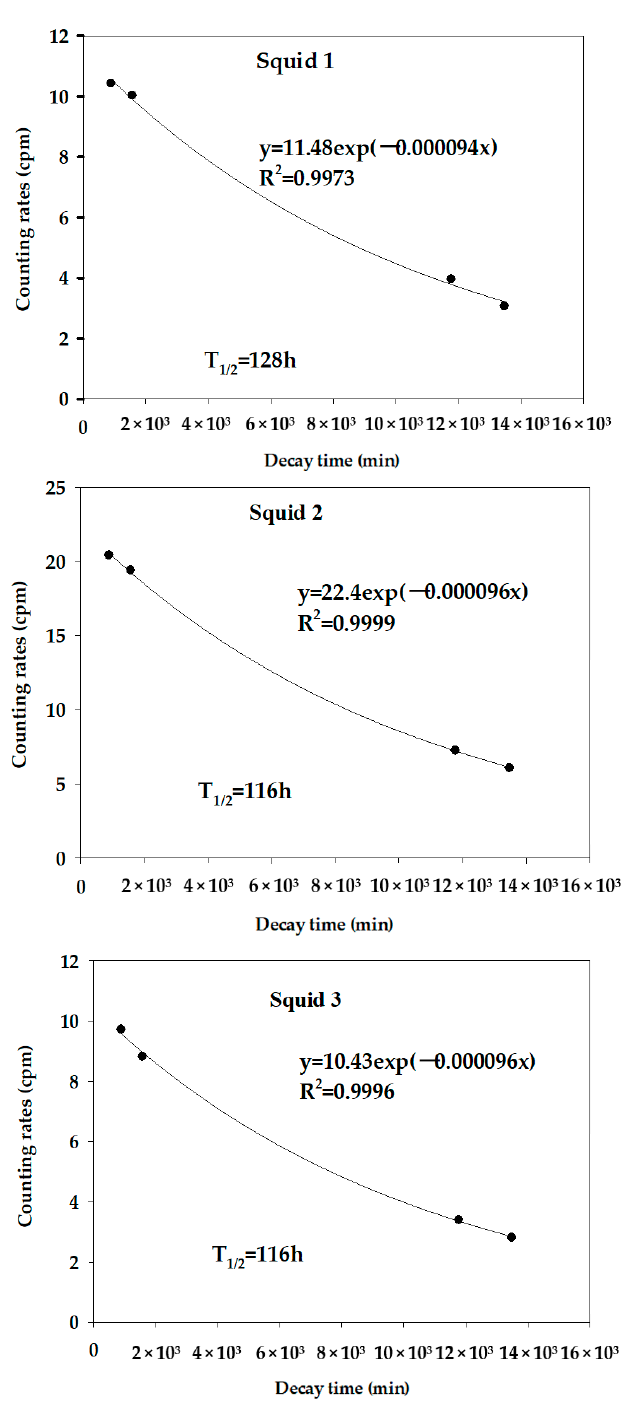
Figure 3. Decay curves of squid samples after solvent extraction with HDEHP.